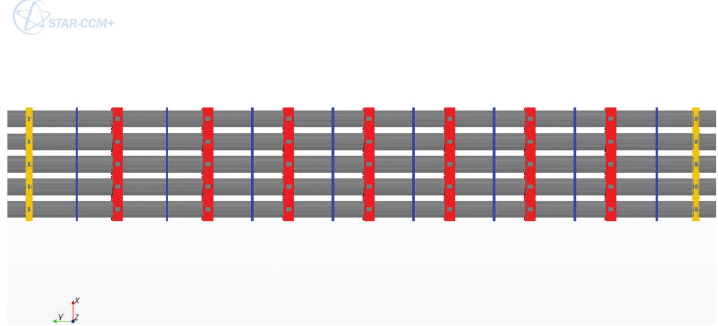
Figure 5: Rods and spacers (red = MV, yellow = NMV, blue =